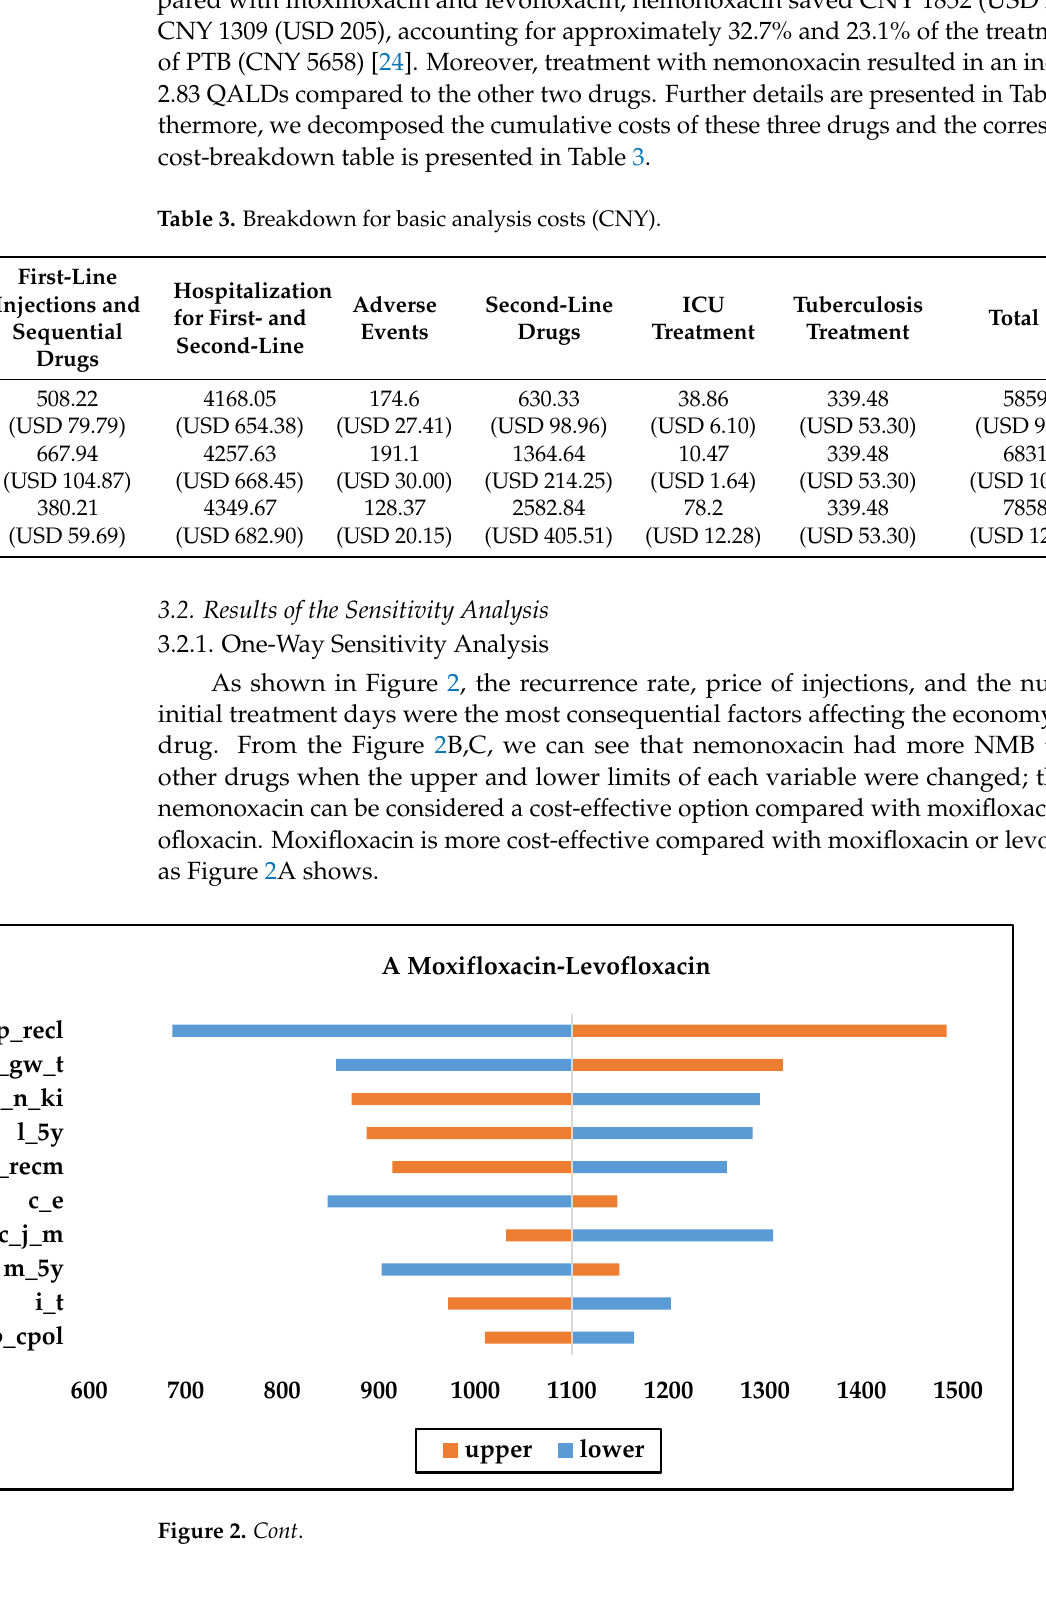
Table 3. Breakdown for basic analysis costs (CNY).